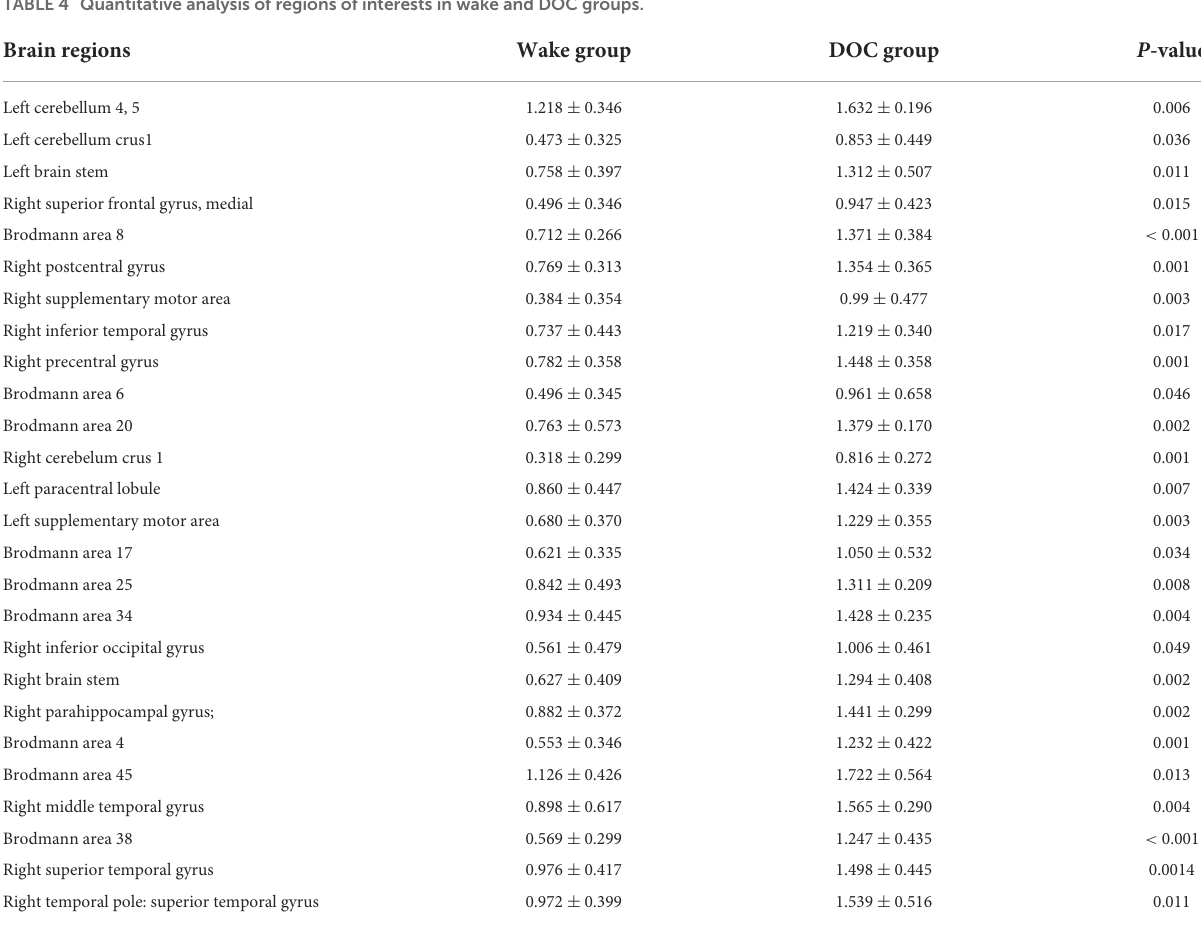
The 26 regions of interest were selected, according to the above comparison results of the wake and DOC groups (Figure 4A). Compared with the wake group (Figure 4B), the DOC group (Figure 4C) had a higher Pearson’s correlation coefficients ( R -values) between each region of interest pair. The difference between groups was statistically significant (FDR corrected, P < 0.05) (Figure 4D). The visualization findings indicated that, compared with the wake group, the strength of functional connectivity between some regions of interest pairs (28.99%) in the DOC group was similar (Figure